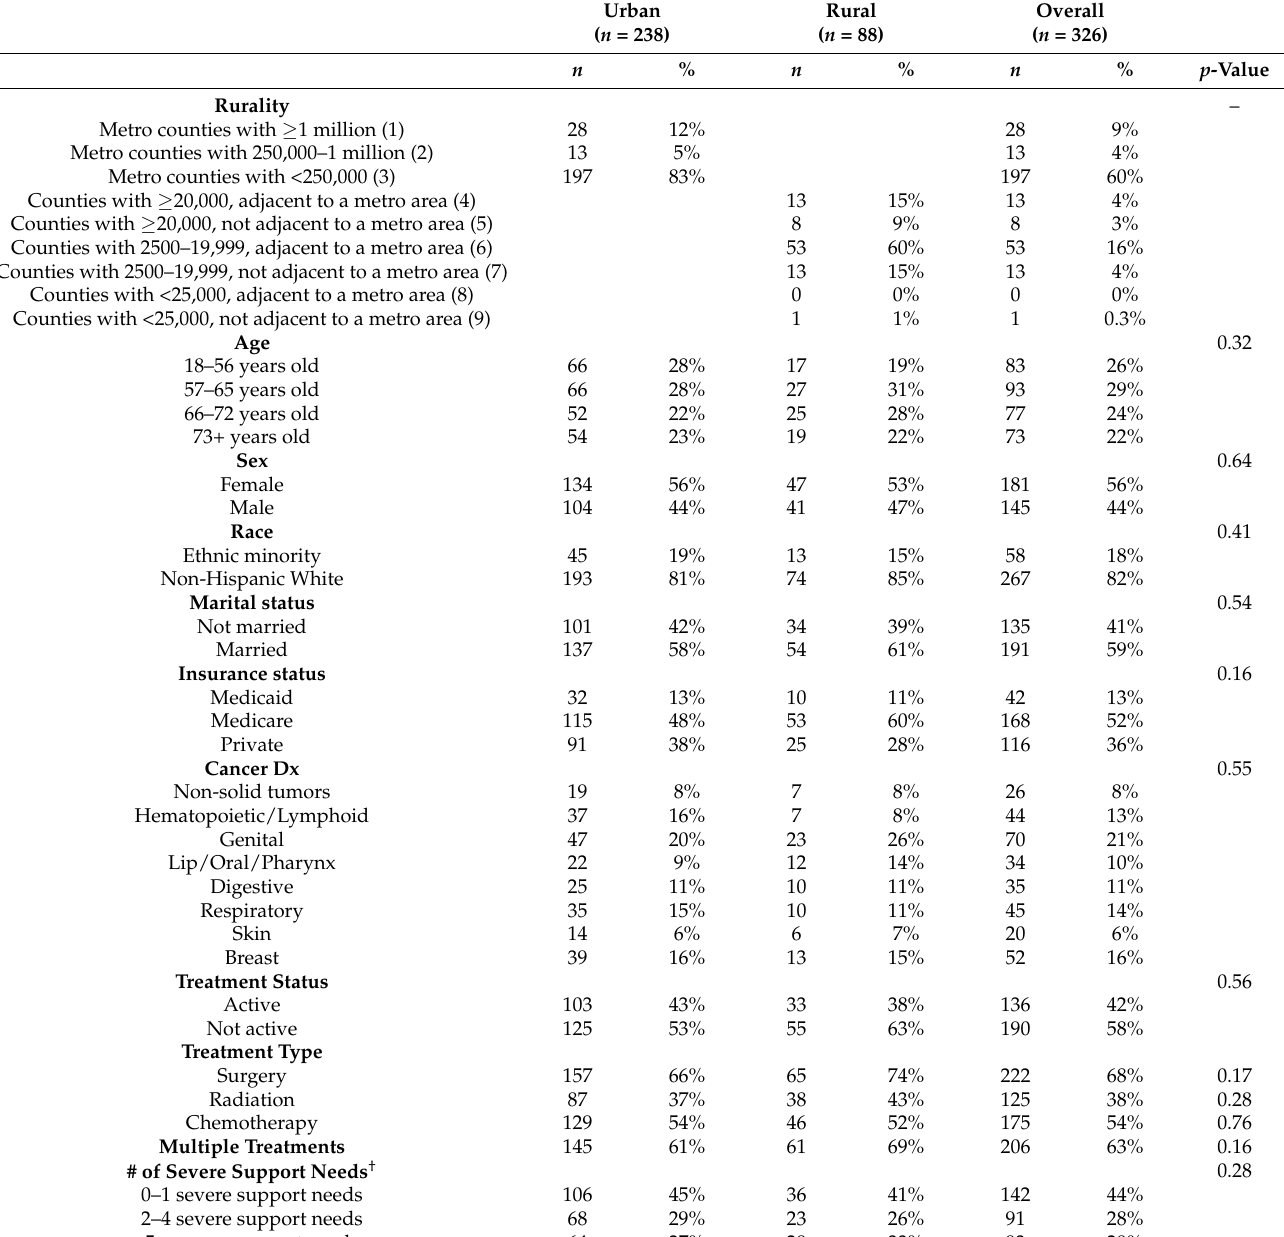
Table 1. Study sample characteristics and crude analyses to assess urban–rural differences in demo- graphic, cancer-related, and severe support needs